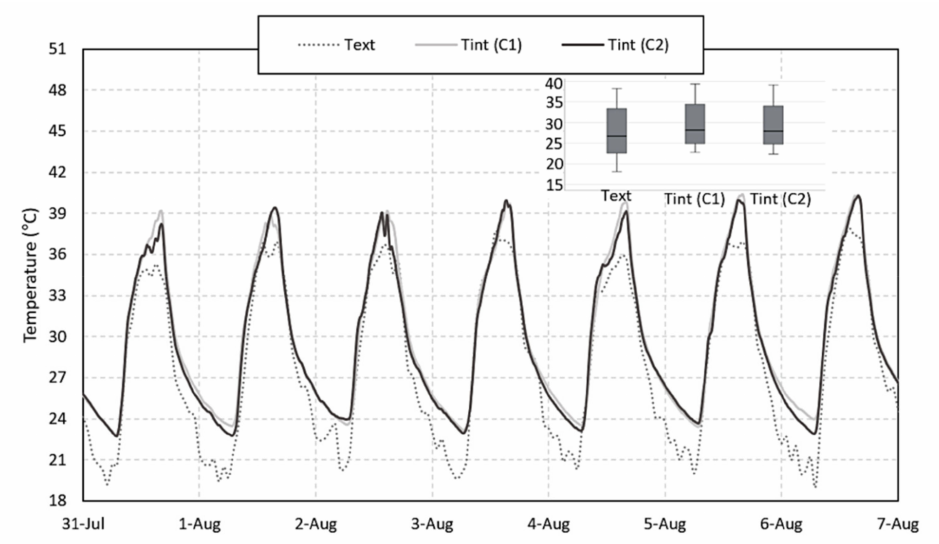
Figure 12. Variation of external and internal temperature in cells C1 and C2 during one week of campaign 2 (application of a low-emissivity reflective film in the attic).